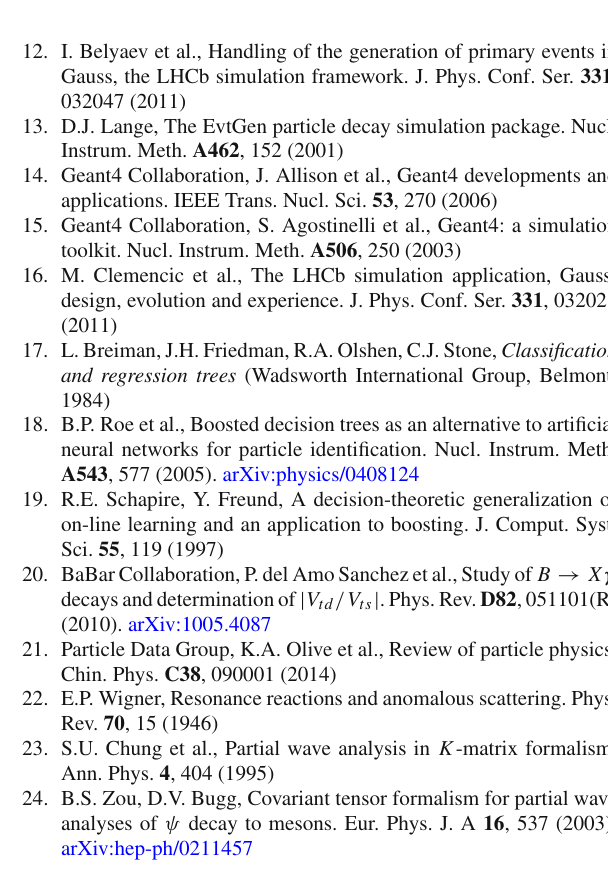
with respect to the K ( 1460 ) − → K ∗ ( 892 ) 0 π − coupling. For each parameter, the first uncertainty is statistical and the second